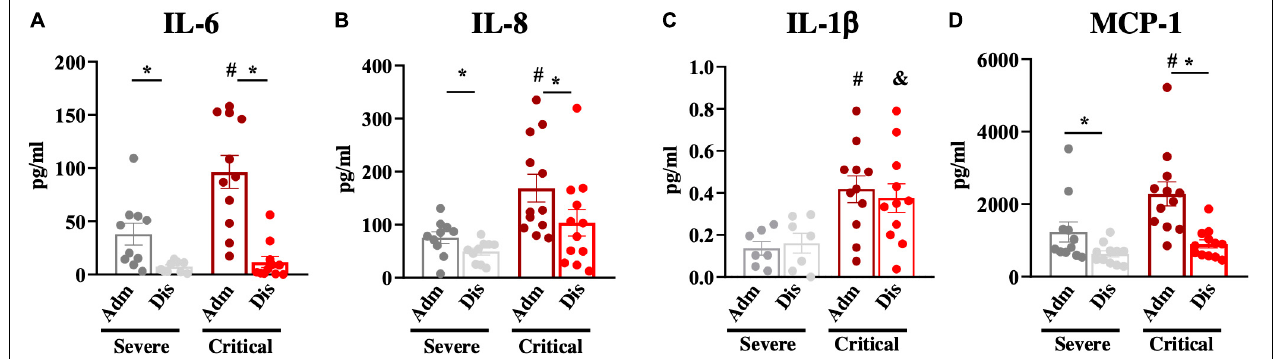
FIGURE 2 | Blood inflammatory markers. Inflammatory markers; interleukin-6 (IL-6; A ), interleukin-8 (IL-8; B ), interleukin-1beta (IL-1 β ; C ), and monocyte chemoattractant protein-1 (MCP-1; D ) were determined in blood samples at hospital admission (Adm) and discharge (Dis). * p < 0.05; # p < 0.05 vs. severe at admission; & p < 0.05 vs. severe at